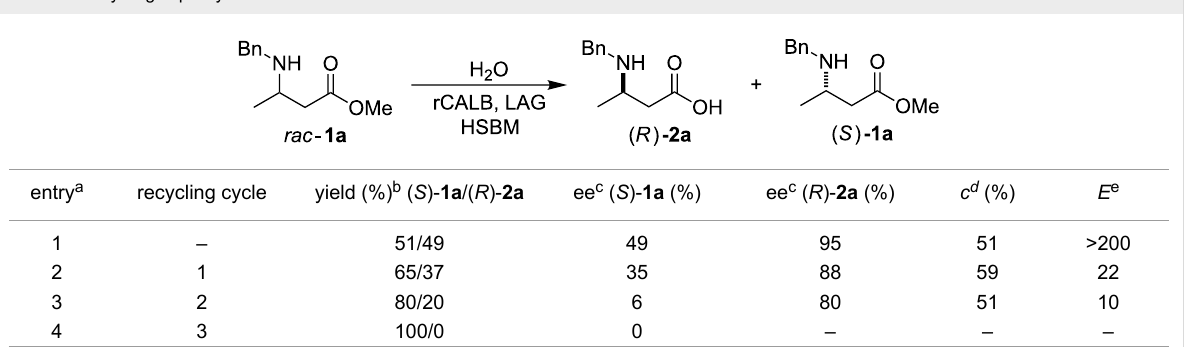
Table 3: Recycling capacity of immobilized CALB under HSBM conditions.